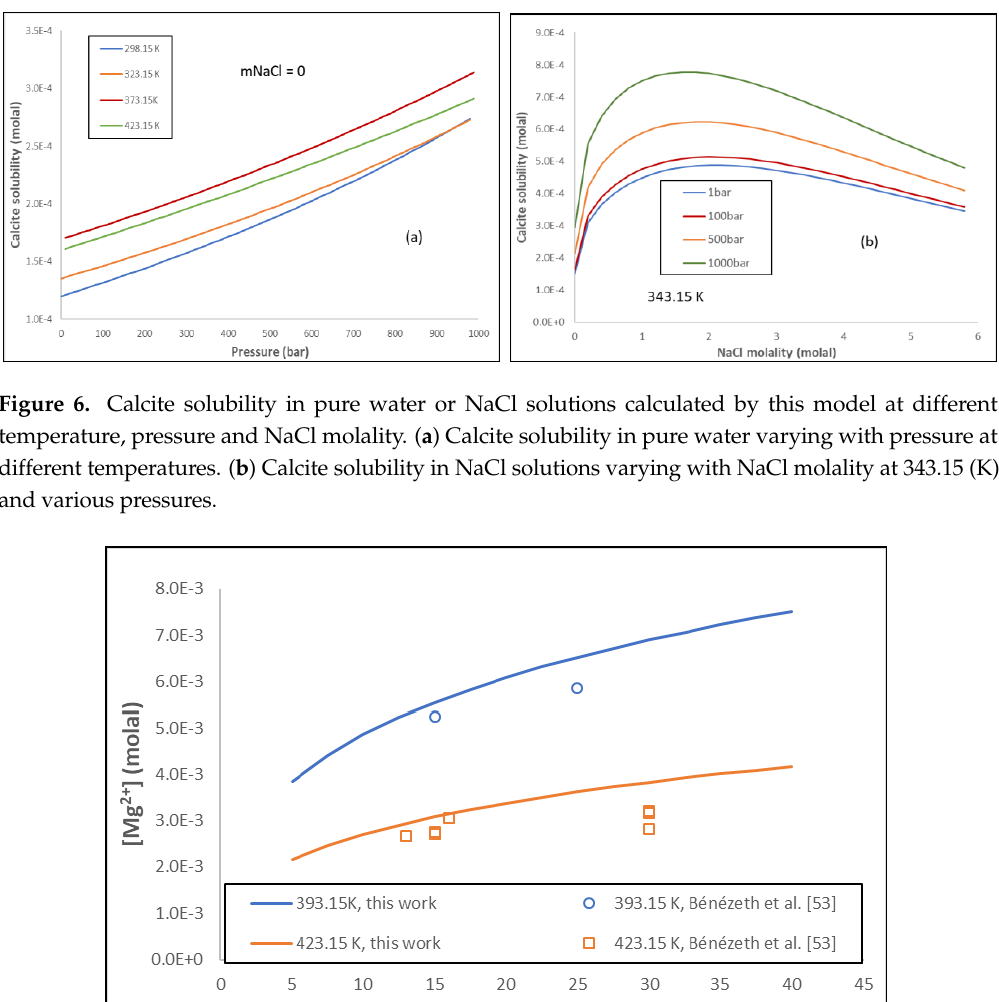
Figure 7. Magnesite solubility calculated by this model (lines) and obtained from the experimental work of Benezeth et al. [53] (dots).